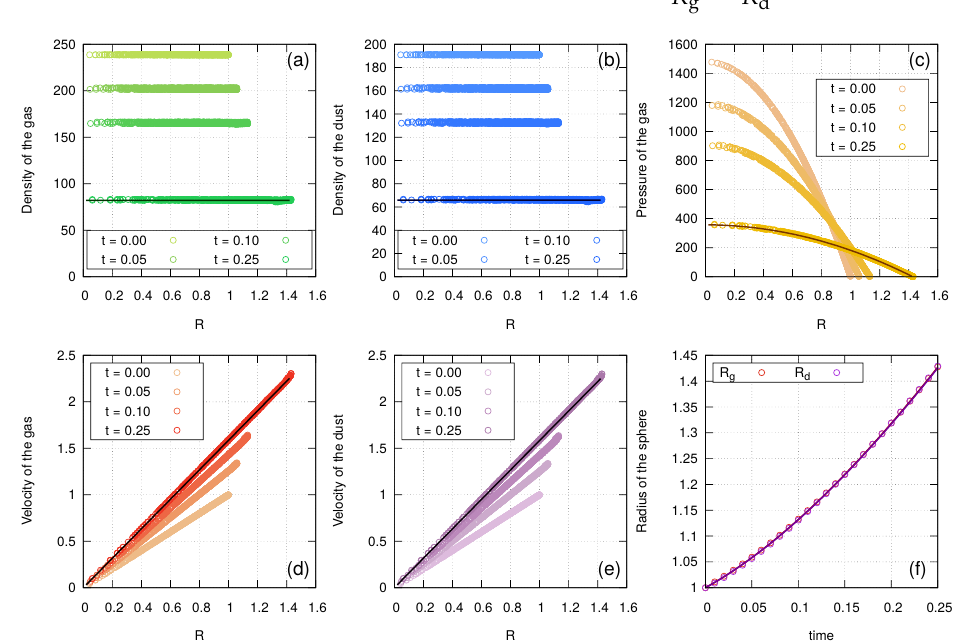
Figure 4. Expansion of a gas and dust ball into vacuum, model S with ε = 0.8 and short relaxation time ( t stop = 0.001). The points show the computed values at four time moments t = 0, t = 0.05, t = 0.1, and t = 0.25, the solid bold line is the analytical solution at the final time t = 0.25. The panels represent (from left to right and from top to bottom): gas density ( a ), dust density ( b ), gas pressure ( c ), gas velocity ( d ), dust velocity ( e ), and radii of the gas and dust balls, respectively ( f ).